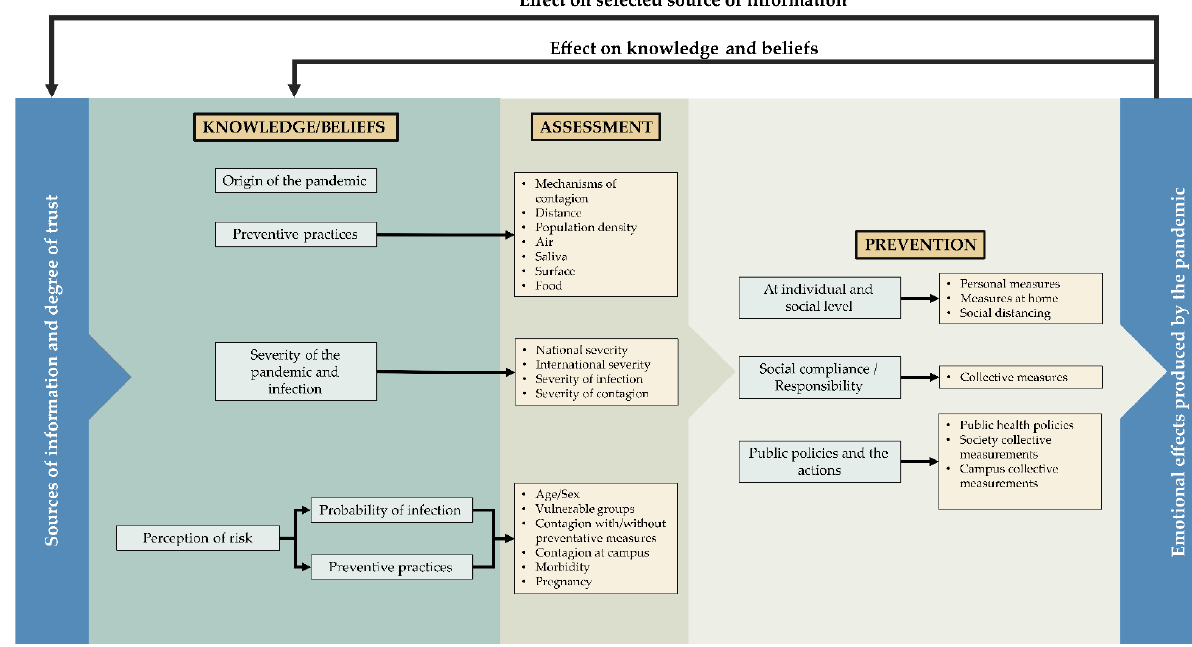
Figure 1. Representation of the conceptual model. The variables of age, sex, civil status (partner/no partner), level of education and institutional position within the university (student/level, academic/administrative staff) were included to characterize the population subgroups.